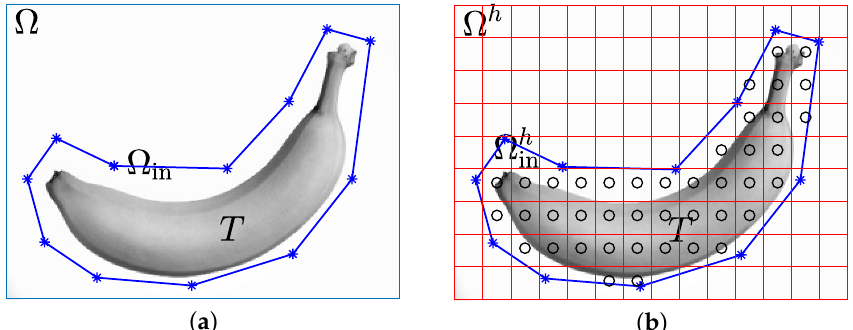
Figure 15. ( a ) Schematic of the complex domain Ω in containing the target image T on the whole domain Ω . ( b ) Its corresponding discrete domain Ω h which is represented by open in